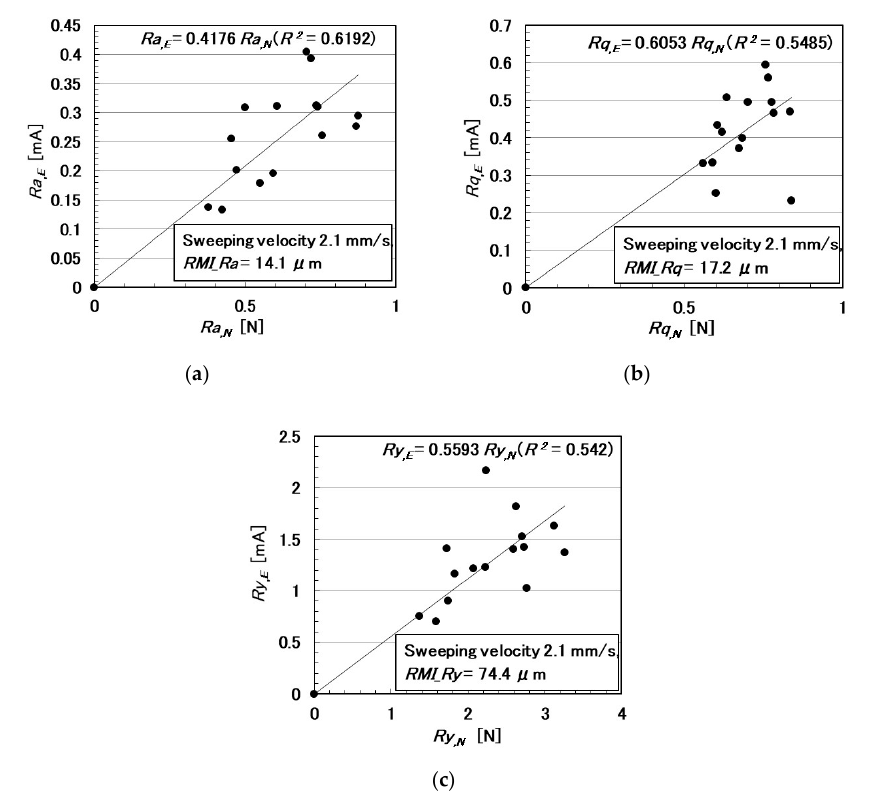
Figure 7. Relationship between electric current and normal force: ( a ) Ra .; ( b ) Rq .; and ( c ) Ry .